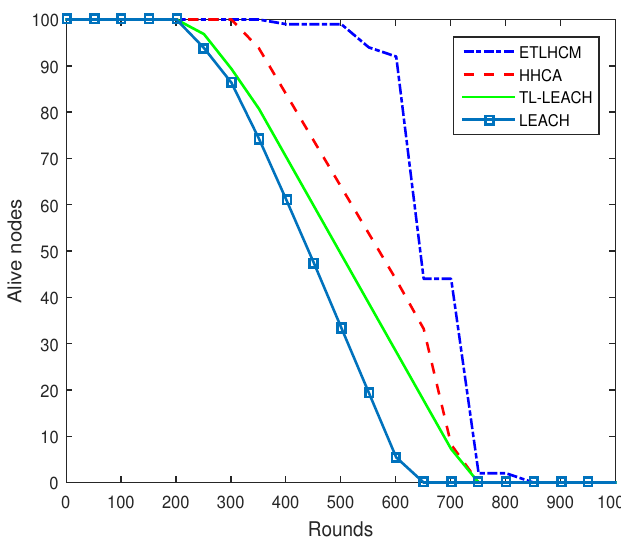
Figure 4. Network lifetime of proposed mechanism is increased by limiting wasteful operations.